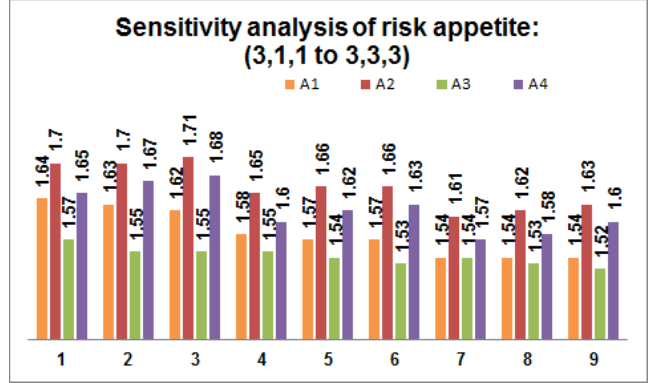
Figure 4. Sensitivity analysis of risk appetite of each DM ((19) 3,1,1 to (27) 3,3,3).